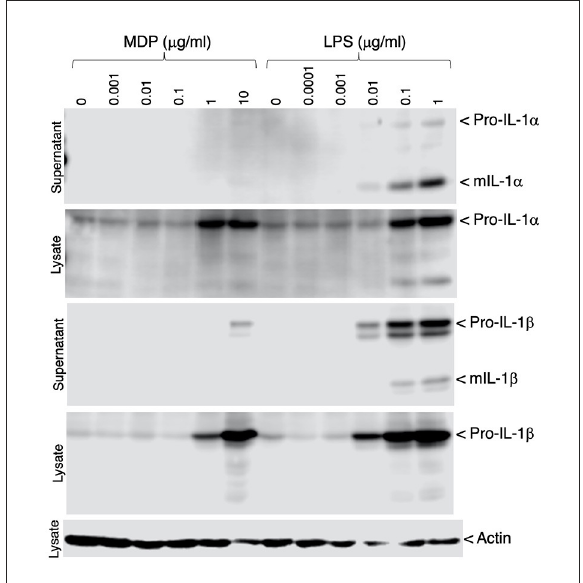
FIGURE4 Production of IL-1 α and IL-1 β in MDP- or LPS-stimulated IPIM. Dose-dependent production of pro-IL-1 α and pro-IL-1 β was detected in cell lysates from IPIM that had been stimulated with MDP or LPS for 3 days ( second and fourth panels ). The secretion of their mature forms (mIL-1 α and mIL-1 β ) into the culture supernatant was detected in the LPS-treated IPIM ( first and third panels ). Actin was detected as an internal control for protein loading in each lane ( fifth panel ). Data are representative of three independent experiments.